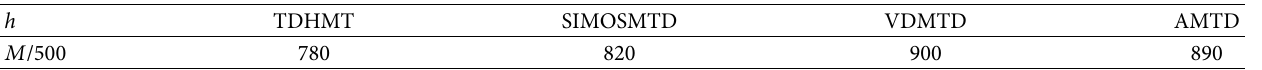
Table 9: Comparison of the NFE of TDHMT with the NFE of other existing methods, namely, SIMOSMTD, VDMTD, and AMTD for Example 4.